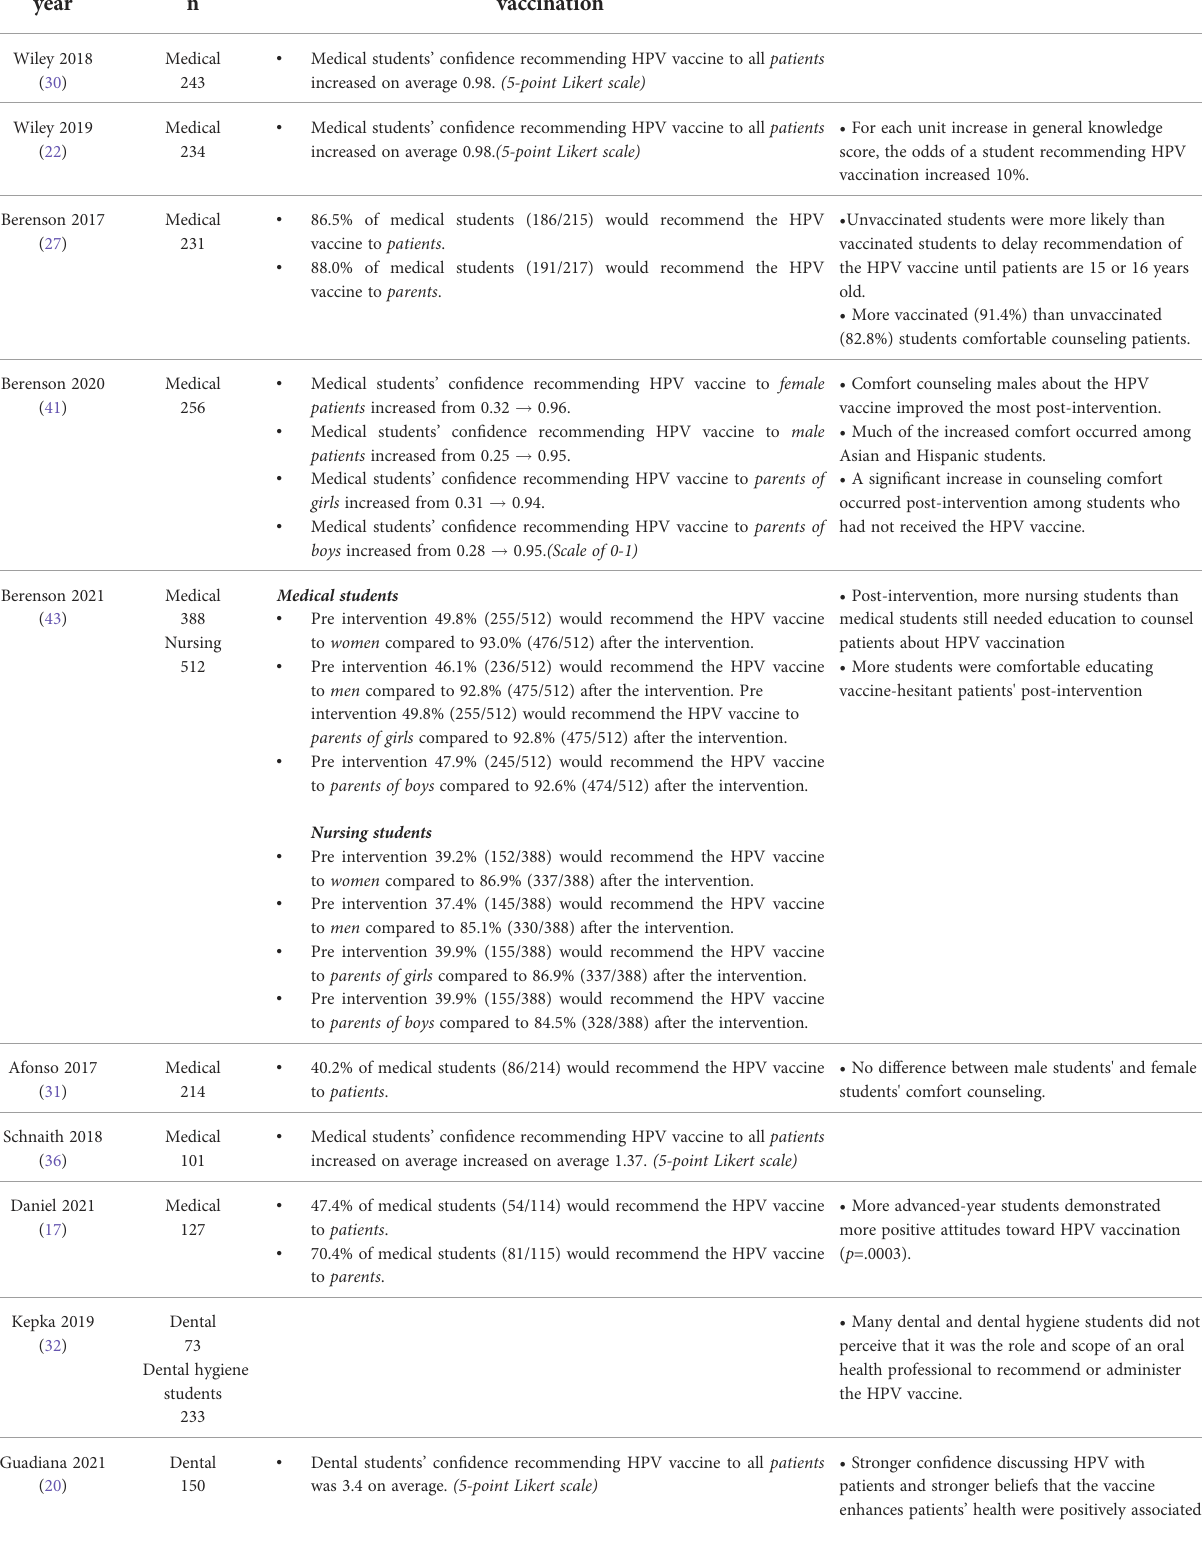
TABLE 7 Counseling